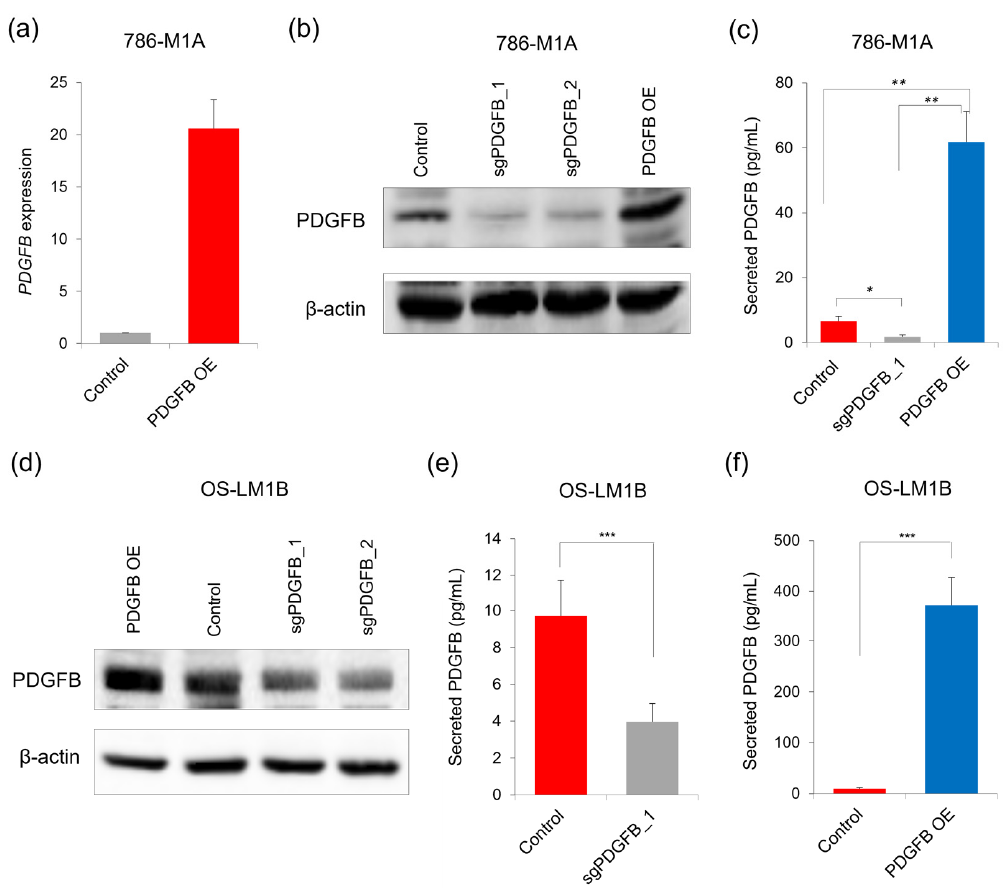
Figure 2. The level of PDGFB secretion by ccRCC cells correlates with intracellular PDGFB expres- sion. ( a ) PDGFB mRNA level in the 786-M1A cells that stably expressed the exogenous PDGFB CDS. Average of two independent experiments. Error bars represent SD. ( b ) Intracellular PDGFB expression in the PDGFB-targeted and PDGFB-overexpressed 786-M1A cells. ( c ) The level of secreted PDGFB in the PDGFB-targeted and PDGFB-overexpressed 786-M1A cells. Average of three inde- pendent experiments. Error bars represent SD. p -value by one-way Anova. ** p < 0.005, * p < 0.05. ( d ) Intracellular PDGFB expression in the PDGFB-targeted and PDGFB-overexpressed OS-LM1B cells. ( e , f ) The secreted PDGFB level of the ( e ) PDGFB-targeted and ( f ) PDGFB-overexpressed OS-LM1B cells. Average of three independent experiments. Error bars represent SD. p -value by two-tailed t -test. *** p < 0.0005.